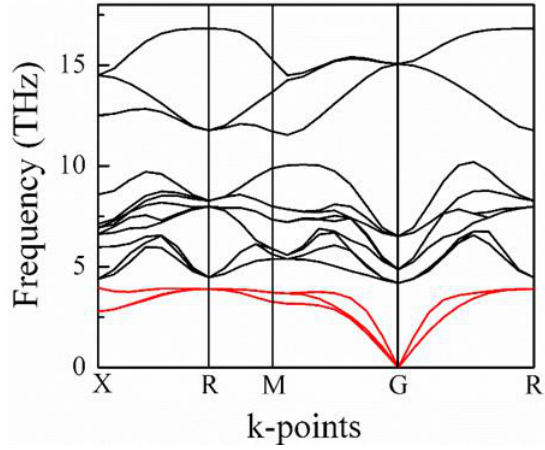
Figure 11. Phonon spectra of BaCuO 3 at zero pressure.